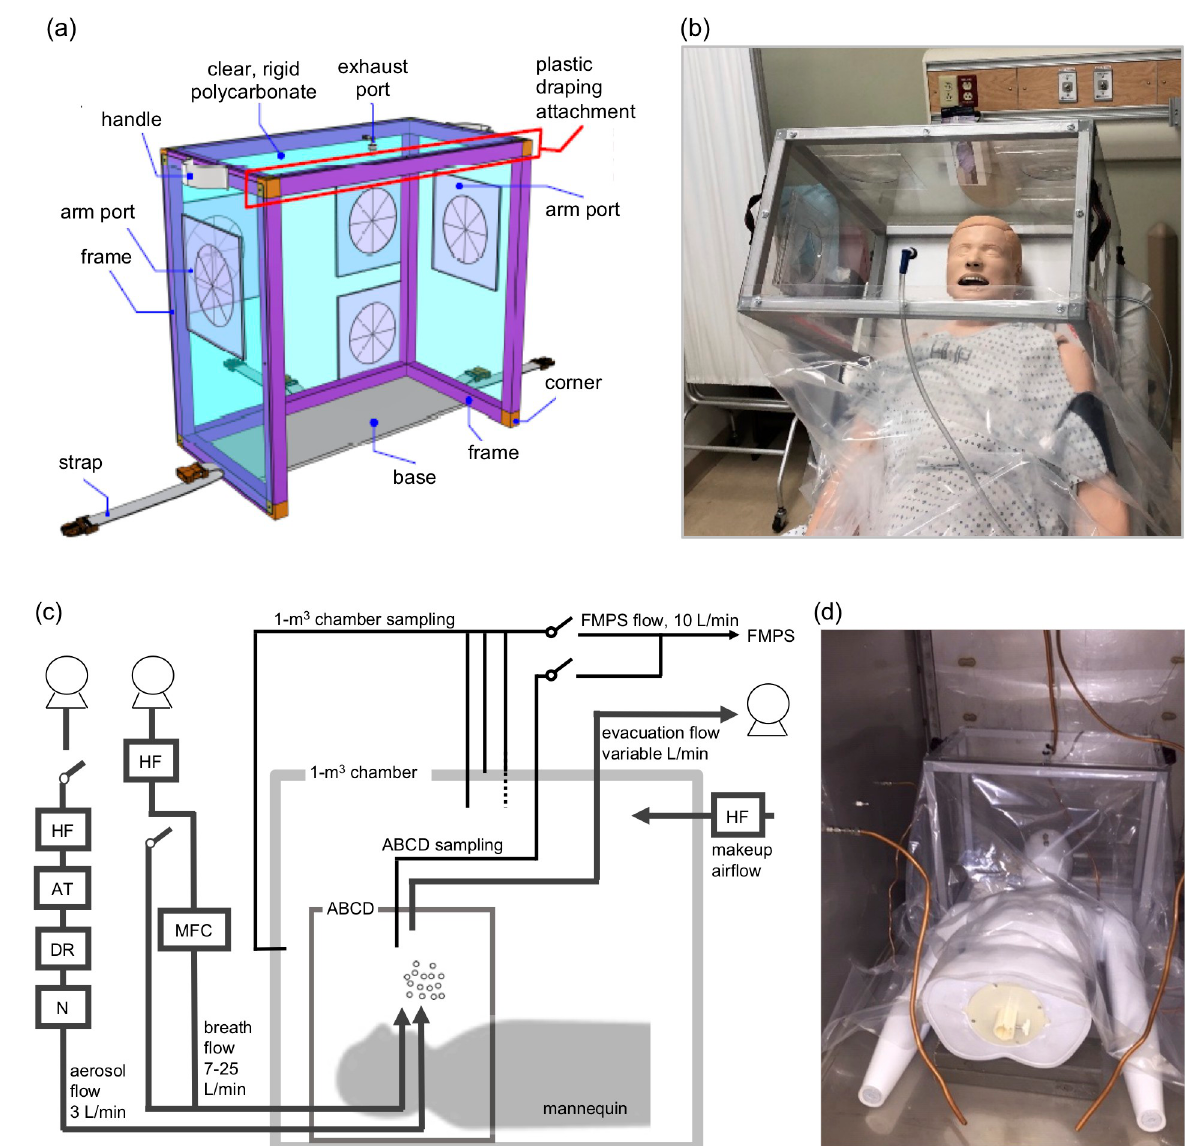
Fig 1. ABCD design and experimental apparatus. (a) Schematic of aerosol bio-containment device (ABCD) and (b) photograph of ABCD in a simulated clinical patient scenario. The ABCD has a volume of 0.1 m 3 and measures 0.52 m high, 0.58 m wide, and 0.34 m deep, and has multiple straps so it can be secured to a bed at different angles. (c) Schematic of 1 m 3 stainless steel, environmental chamber system for aerosol evaluation testing, and (d) photograph of mannequin and ABCD within the chamber. Chamber system abbreviations; HF = HEPA filter; AT = atomizer; DR = diffusion drier; N = neutralizer; MFC = mass flow controller; FMPS = TSI Fast Mobility Particle Sizer 3091, which measures particles in range of 0.0056 to 0.56 μ m in size-resolved basis over 32 bins at a time-resolution of 1 s.